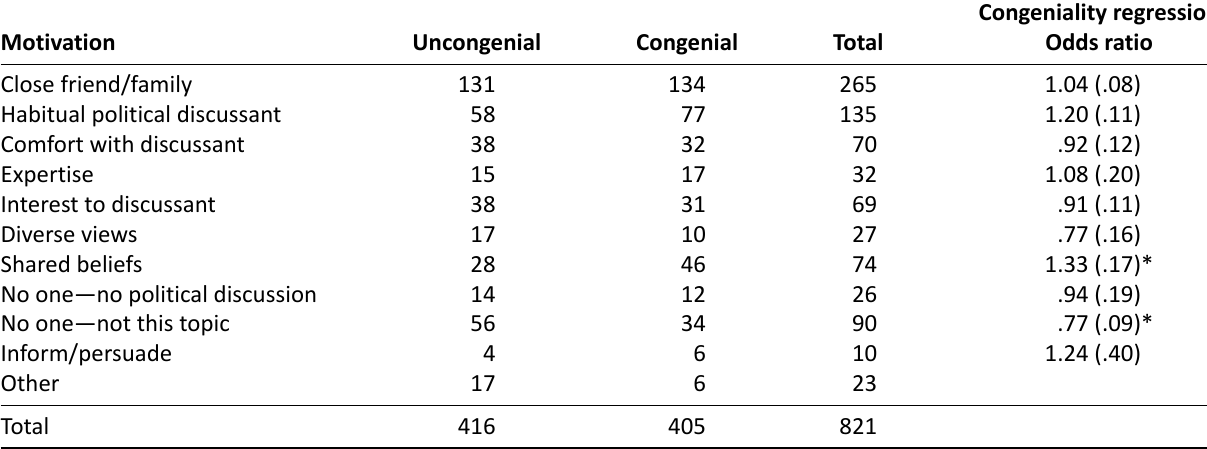
Table 1. Open-ended responses for network selection motivations as predicted by news congeniality.